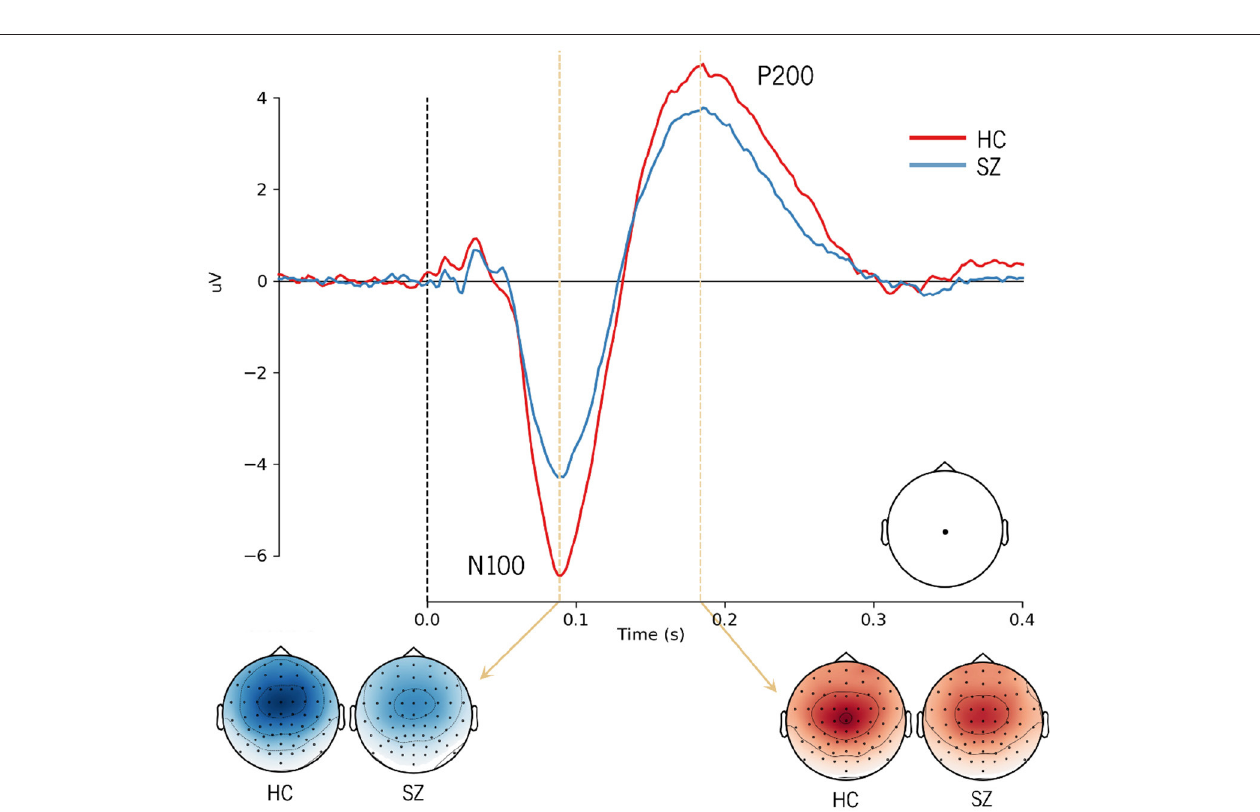
FIGURE 2 | Grand average ERP waveforms showing the N100 and P200 responses to external sounds over Cz electrode in healthy subjects and SZ patients. The topographic distribution of the N100 and P200 components is also shown in both